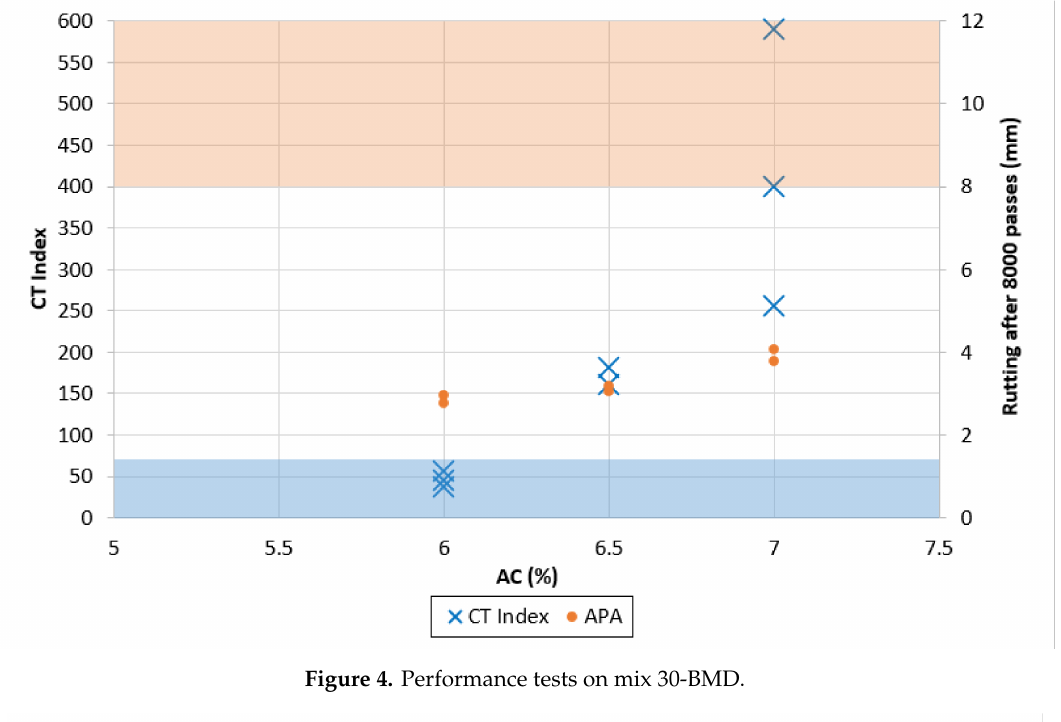
Figure 4. Performance tests on mix 30-BMD.